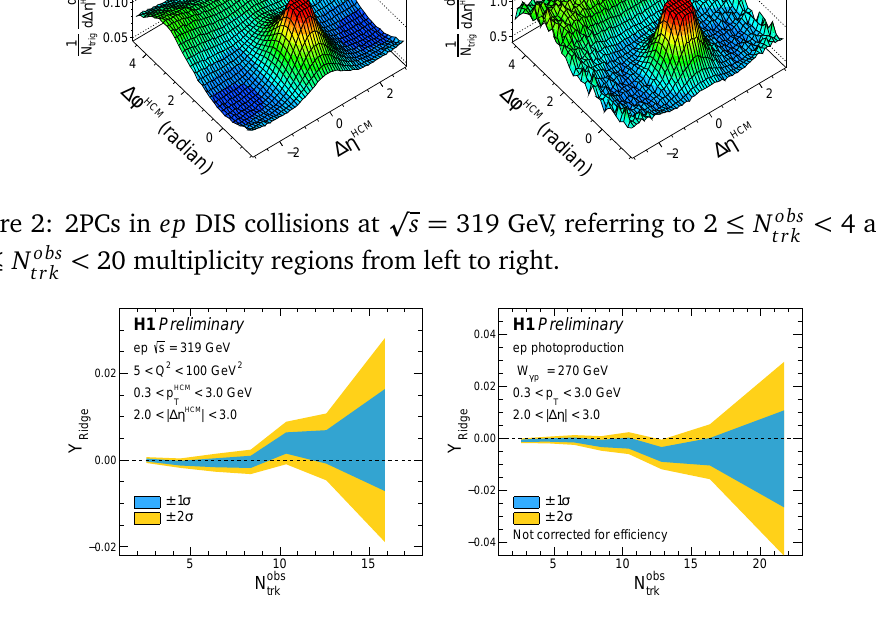
Figure 3: Ridge yield limits for 1 σ and 2 σ are set versus multiplicity in ep DIS process (cid:112) s = 319 GeV and photoproduction process at at referring to 2.0 < ∆ η < 3.0